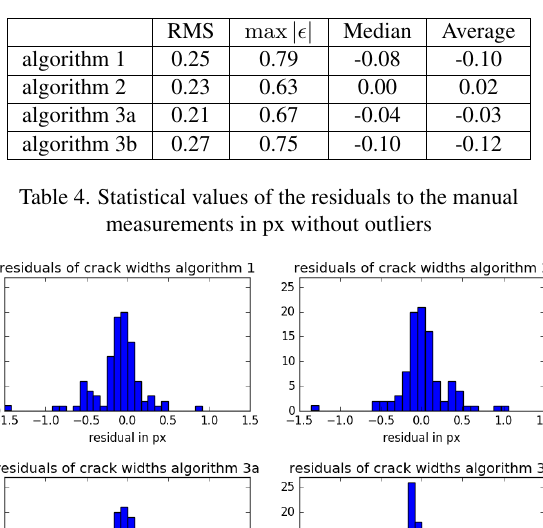
Concerning the values marked with algorithm 3a, the translation is ignored for the residual. In case of algorithm 3b, the translation (cid:126)t along the crack is included in the difference because the manual